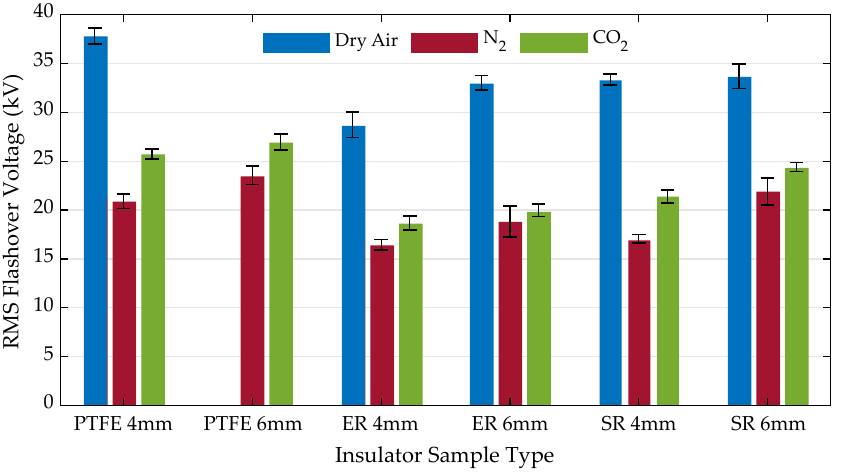
Figure 7. Flashover voltage (FOV) test results for six different insulator samples in dry air, nitrogen (N 2 ) and carbon dioxide (CO 2 ), all at 1bar absolute pressure. Here, arithmetic mean values are depicted together with the corresponding standard deviations after 10 voltage applications. ER stands for epoxy resin while SR for silicone